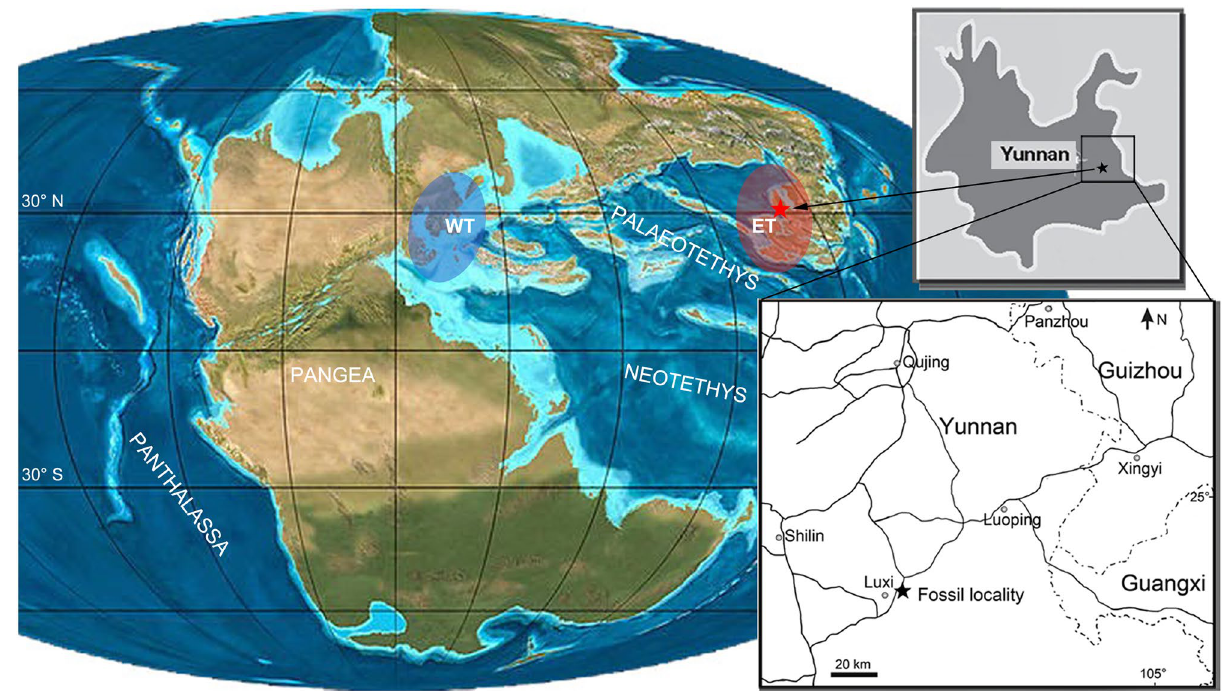
Figure 1. Locality map. The fossil locality is indicated by a star. The Middle Triassic (Anisian) palaeogeography is modified from ref. 37 , with the eastern Tethyan realm (ET, red) and western Tethyan realm (WT, blue)